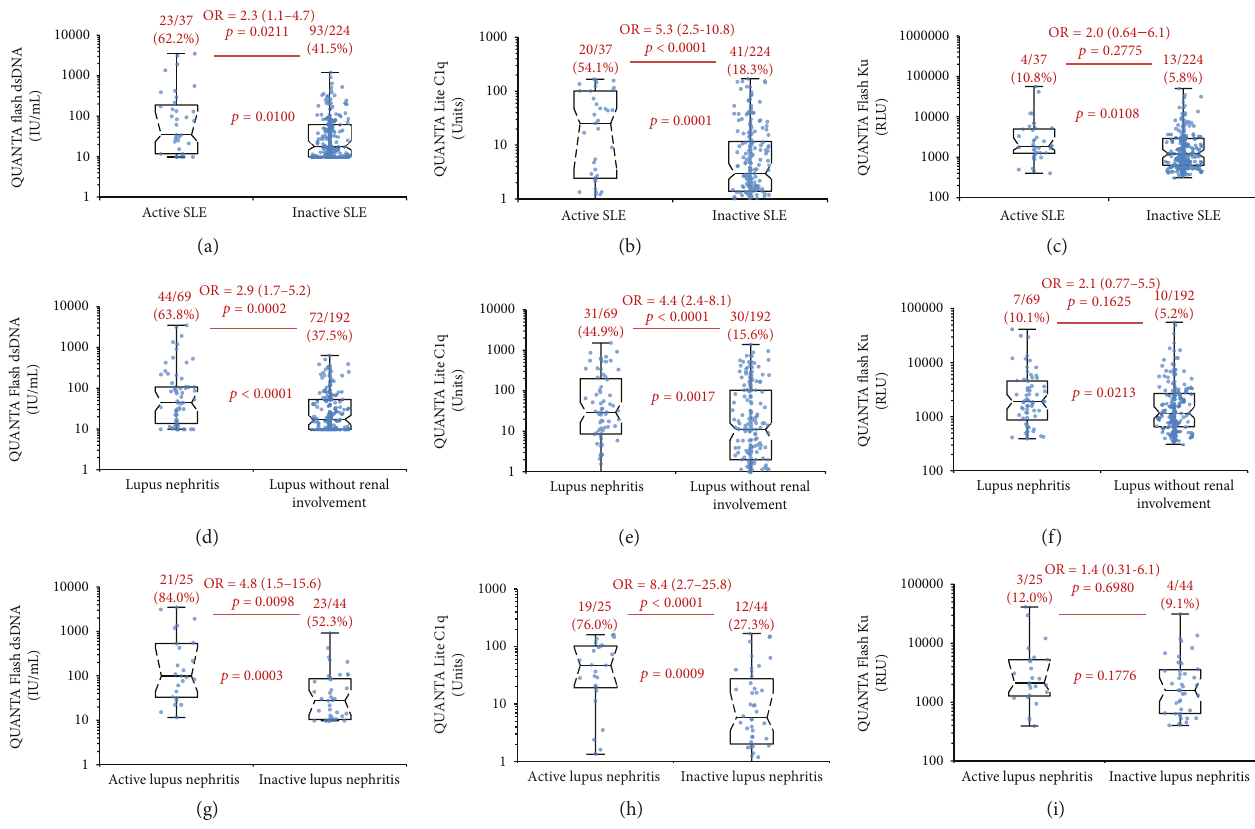
Figure 1: Comparative antibody titer distribution of anti-dsDNA, anti-C1q, and anti-Ku antibodies among patients with active versus inactive SLE (a – c), lupus nephritis versus lupus without renal involvement (d – f), and active versus inactive nephritis (g – i). The prevalence of each marker and the signi fi cance level of the comparisons between groups are indicated in red text. The acronyms IU/mL and RLU stand for international units/mL and relative light units, respectively, which are assay unit values generated from the QF CIA